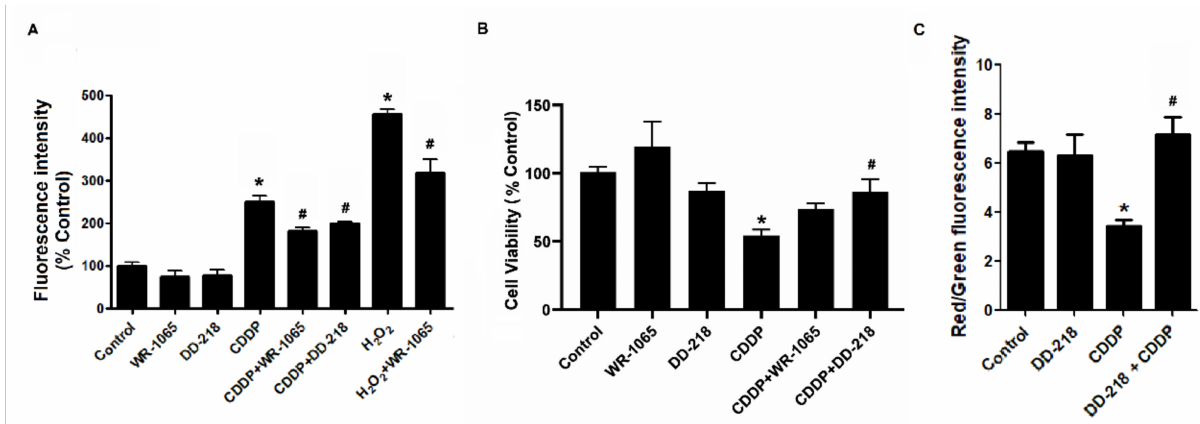
Figure 5. Effects of DD-218 on CDDP-induced intracellular ROS accumulation and mitochondria function in renal tubular cells. ( A ) Intracellular ROS levels of RPTEC/TERT1 cells were measured following treatment for 30 min with: 0.1% DMSO